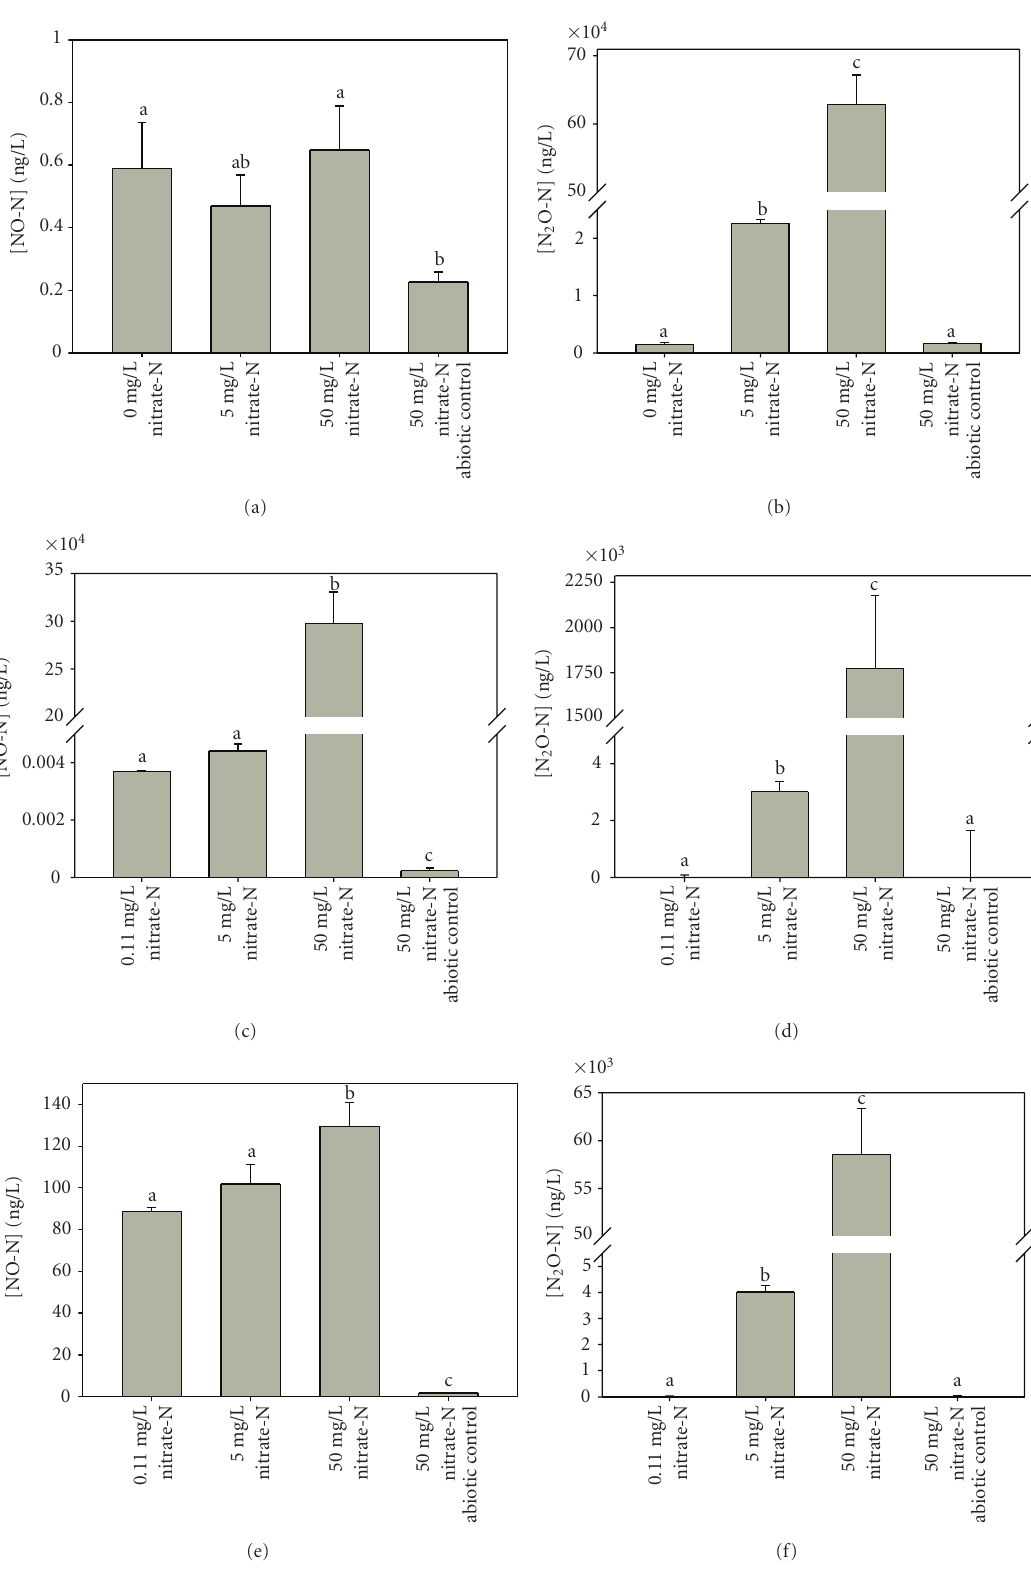
Figure 2: NO-N and N 2 O-N concentrations produced after 24 hours of anaerobic incubation of the human fecal microbiota in mineral medium (a), (b), nonbu ff ered feed medium (c), (d), or bu ff ered feed medium (e), (f) with or without the addition of nitrate ( n = 3). Significant di ff erences are indicated with a, b, or c ( P < . 05). Results are means ± standard deviation of 3 incubations of fecal suspension from 1 representative